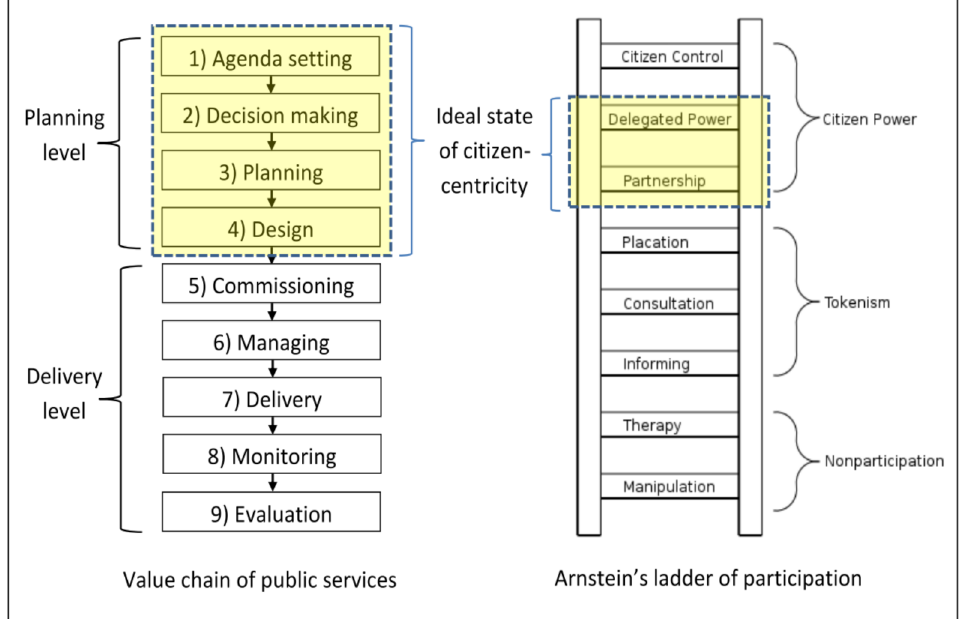
Figure 2. Authentic state of citizen participation, derived from